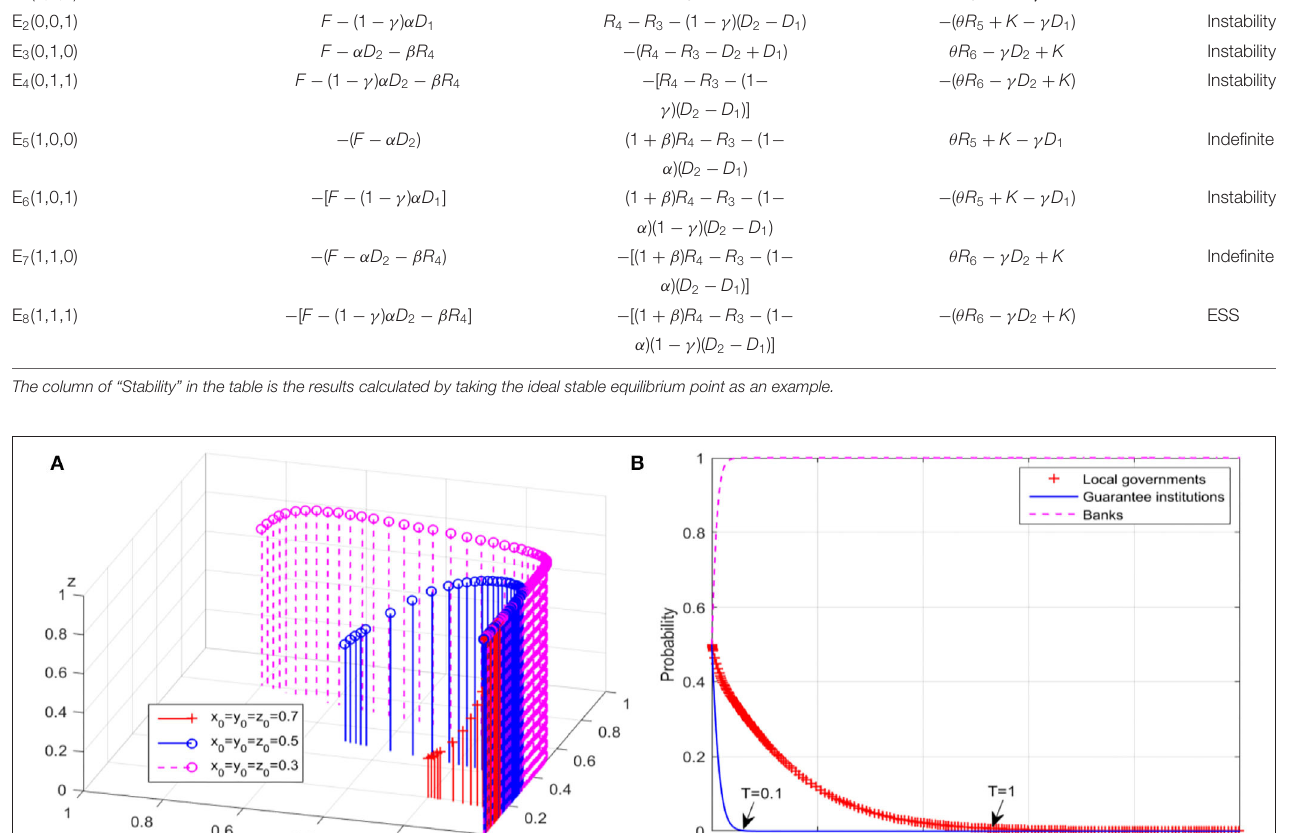
high, medium, and low and the values of 0.7, 0.5, and 0.3